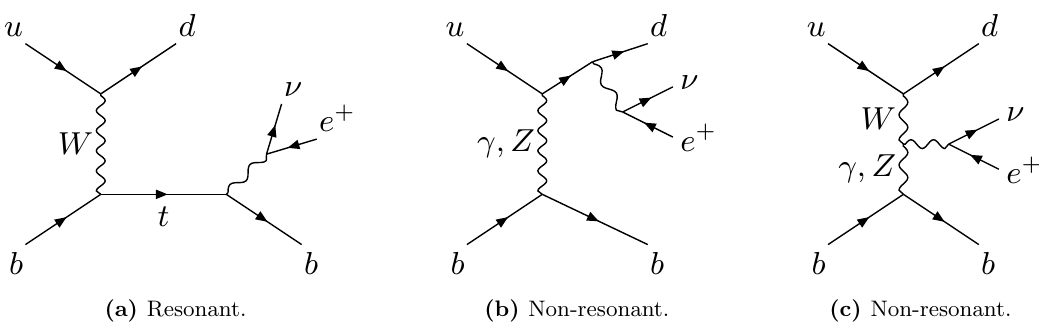
Figure 1. Sample Feynman diagrams of resonant and non-resonant contributions at LO